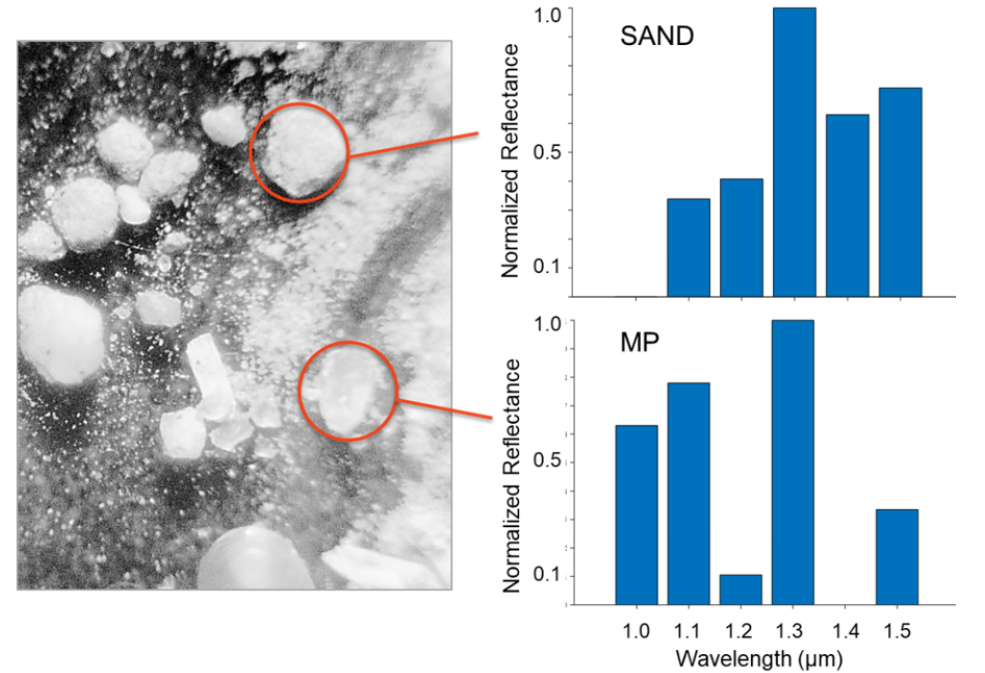
Figure 7. A surface with both MP and sand is imaged with the six SWIR filters. The relative intensity of the sand ( top circle ) and plastic ( bottom circle ) are distinct for the different SWIR filters.